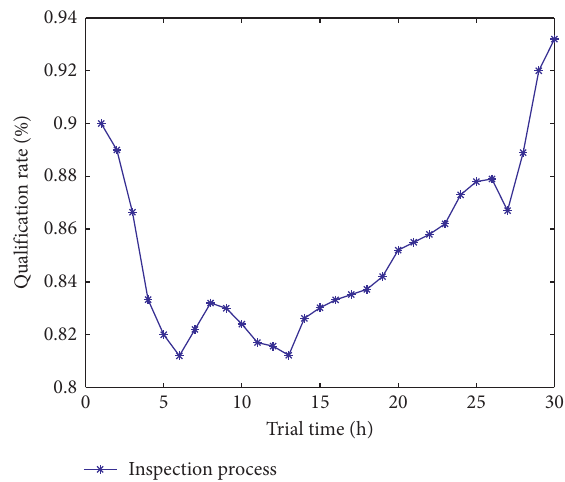
Figure 3: Qualification rate of each